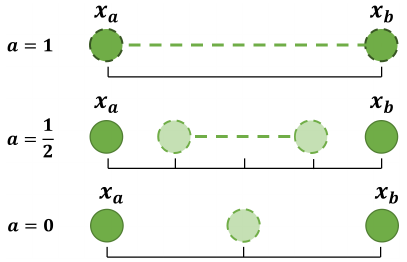
Figure 5. x a and x b are the two original samples, the circle with a dashed border represents the synthesized sample, and the dashed straight line represents the range of the sample synthesis. Assuming that a = 1, the range of sample synthesis is between x a and x b , and the synthesis location is completely determined by the random parameter r . Assuming that a = 1 locations is reduced by half. Assuming that a = 0, the sample is synthesized at the midpoint of x a and x b